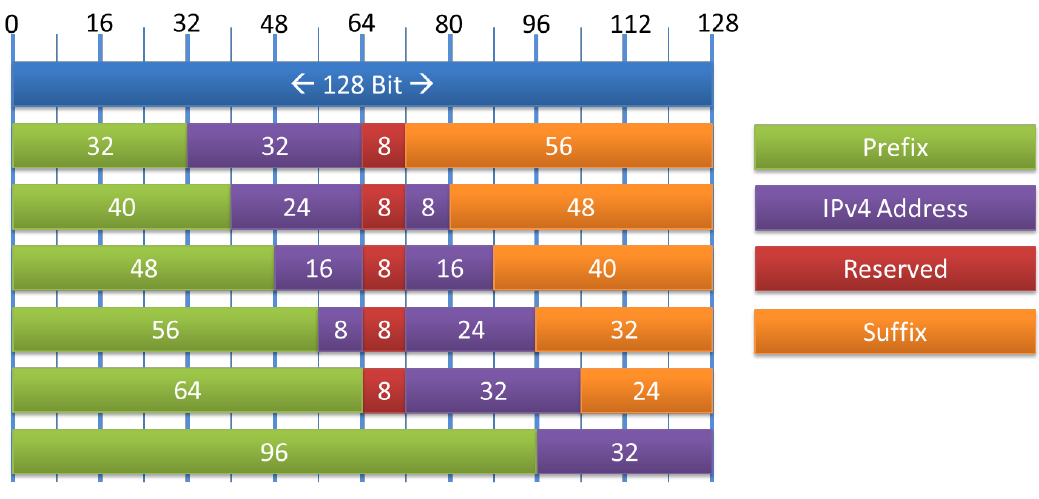
Figure 3. IPv4 embedded IPv6 address formats